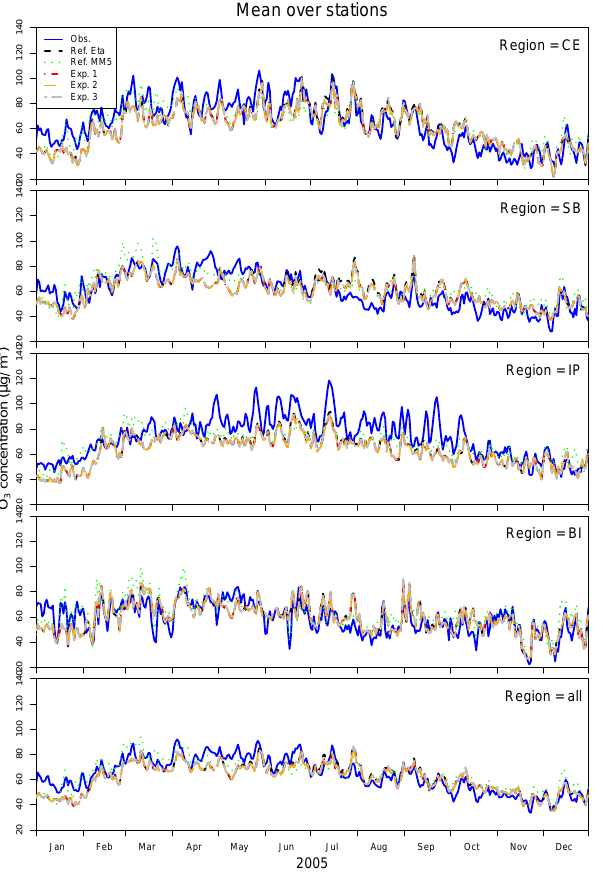
Fig. 8. Time-series of daily-averaged O 3 concentrations for the different regions indicated in Fig. 1b. Fig. 8. Time series of daily-averaged O 3 concentrations for the dif- ferent regions indicated in Fig. 1b.